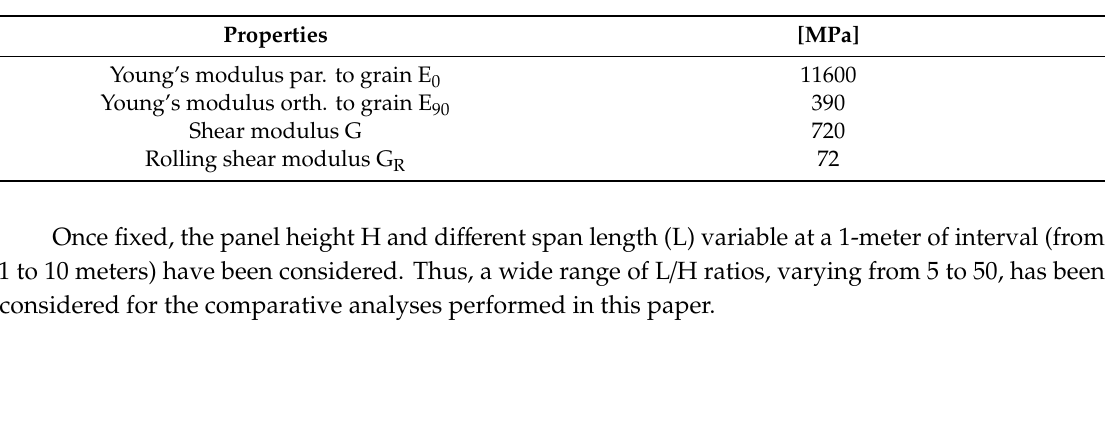
Table 1. Timber elastic